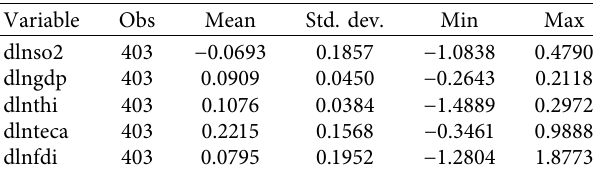
Figure 4: Changes in SO 2 emissions and FDI in China (2004–2020). Note: the axis on the left is the total SO 2 emissions of 31 provincial administrative regions in mainland China from 2004 to 2020, and the unit is 10,000 tons; the axis on the right is the total amount of FDI of the 31 provincial administrative regions in mainland China from 2004 to 2020, and the unit is 1 billion US dollars. The FDI values here are the total investment data of foreign-invested enterprises, and all data were quoted from the China Statistical Table 1: Descriptive statistics of main variables.